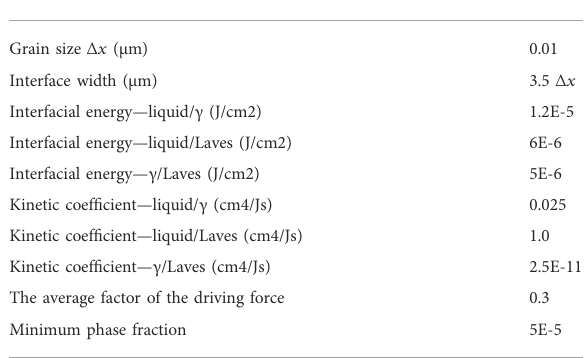
TABLE 1 Simpli fi ed composition of Inconel 718 alloy in multiphase- fi eld model. Element